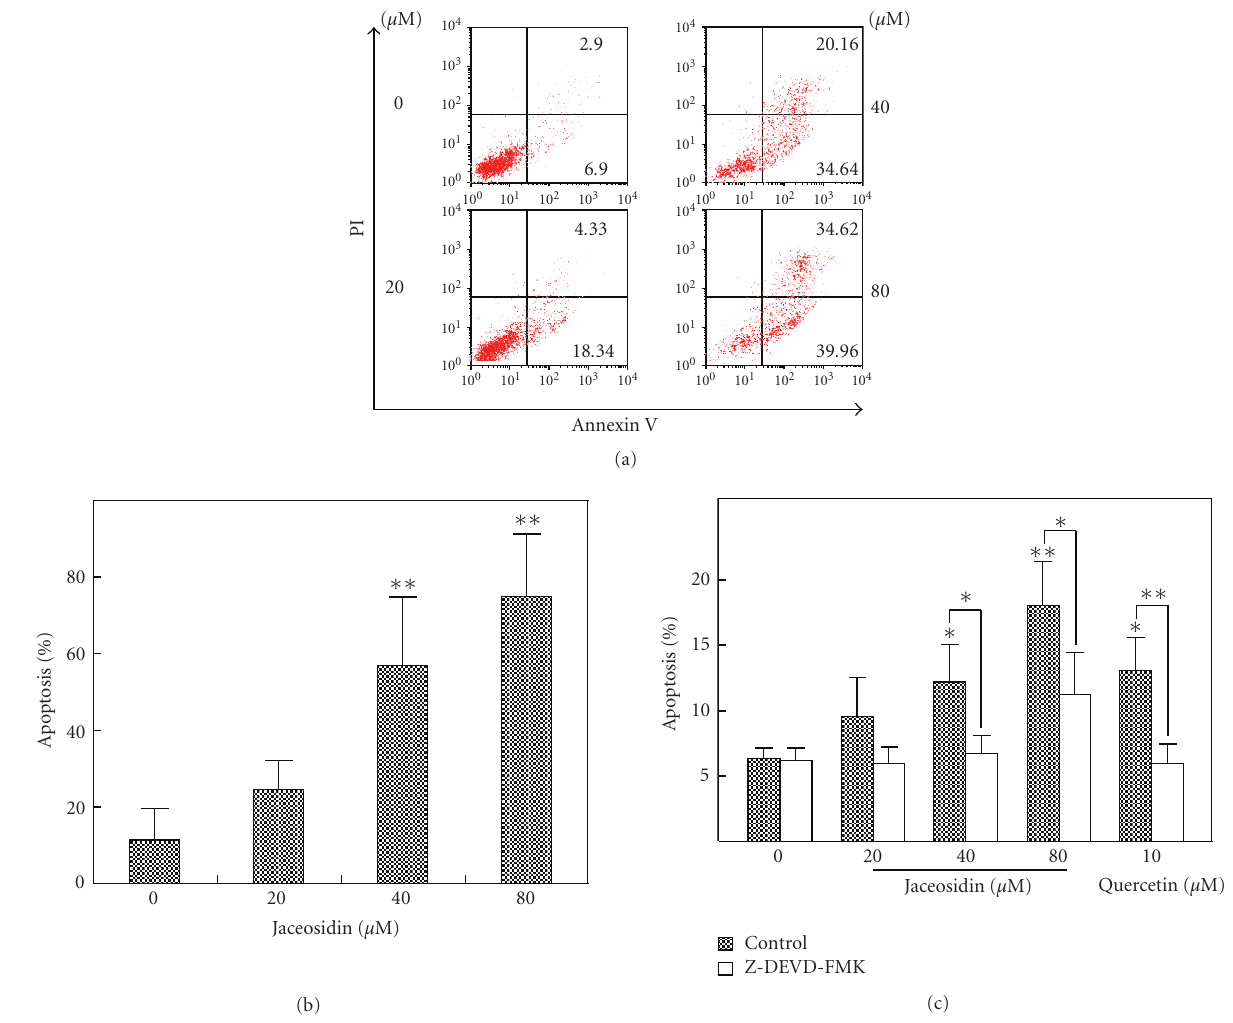
Figure 2: Jaceosidin promotes apoptosis of CAOV-3 cells in a caspase-3-dependent manner. CAOV-3 cells were seeded in 12-well-plate overnight, and then were treated with di ff erent concentrations of jaceosidin or 10 μ M quercetin in the presence or absence of 100 μ M Z- DEVD-FMK for 24 hours. Annexin-V/PI stain was used to measure apoptosis rate. Apoptosis rate is measured by flow cytometry. (a) The results are representative of three separate experiments. (b) Data are expressed as a histogram of mean ± s.d. of three independent experiments. (c) E ff ect of Z-DEVD-FMK on the proapoptotic activity of jaceosidin. Each datum indicated mean ± s.d. of three independent experiments. ∗ P < . 05, ∗∗ P < . 01 (Dunnett’s